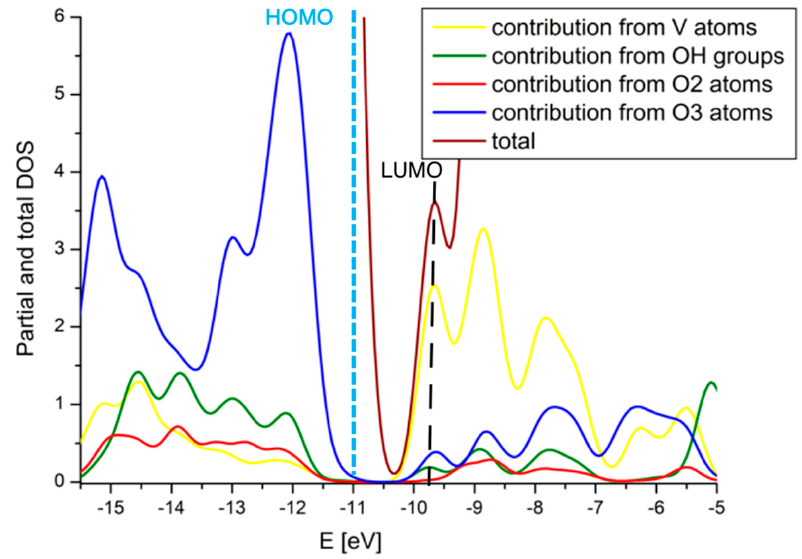
Figure 12. DOS plot of the V 20 O 62 H 24 2 + cluster.